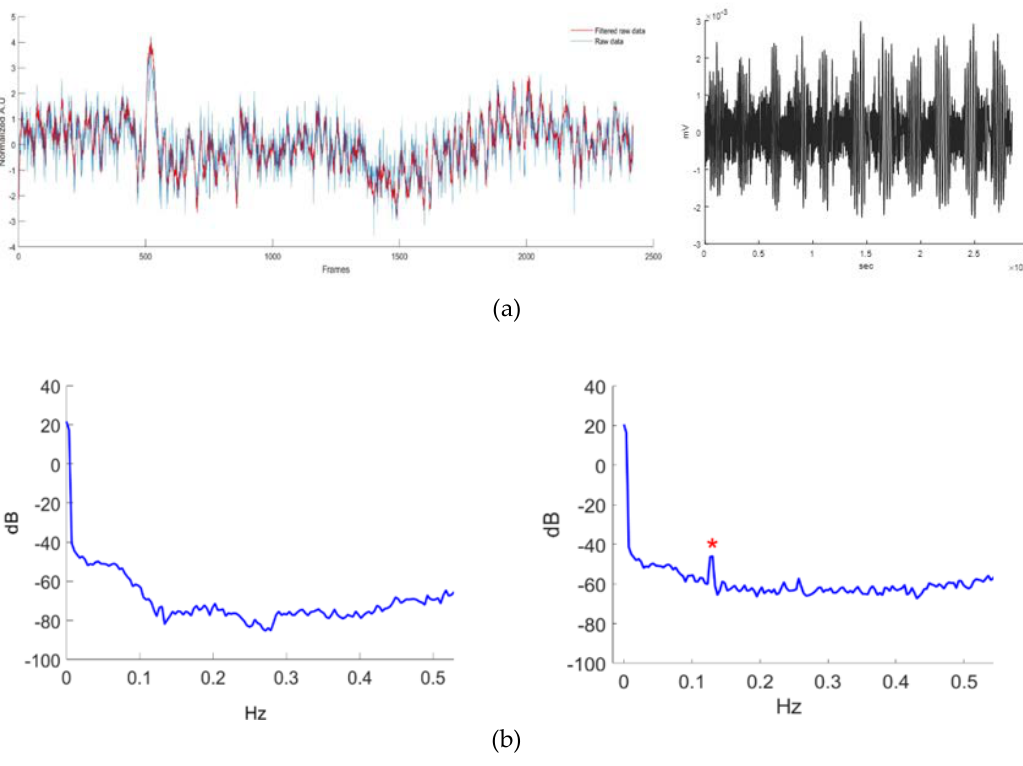
Figure 2. The top left graphic shows a time series of an average of the optical channels (2048) over time. The blue plot shows raw di ff use optical tomography (DOT) data and the red plot shows DOT data after filtering with the Bayesian algorithm at a wavelength of 760 nm. The right top graphic shows the respiration recorded continuously at 4 kHz using AD Instrument ML870 / PowerLab16 / 30. The bottom graphic depicts power spectrum densities for the unfiltered signal ( a ) and the signal extracted by the Bayesian-filtering method ( b ). Note the respiration frequency (*) has been isolated from the raw DOT